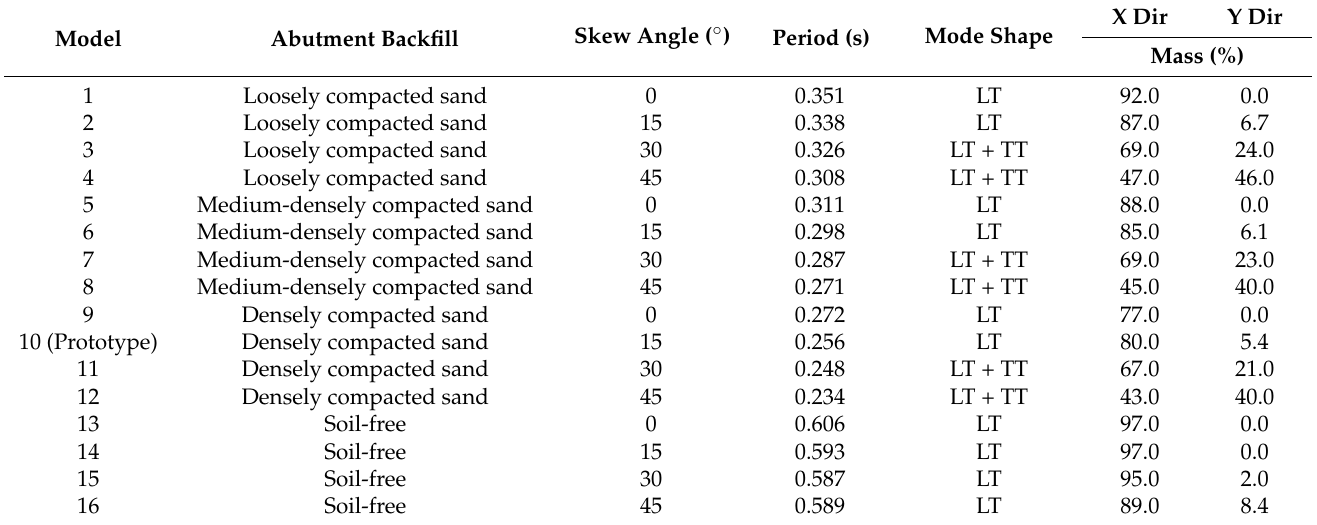
Table 2. Dynamic properties of SIAB